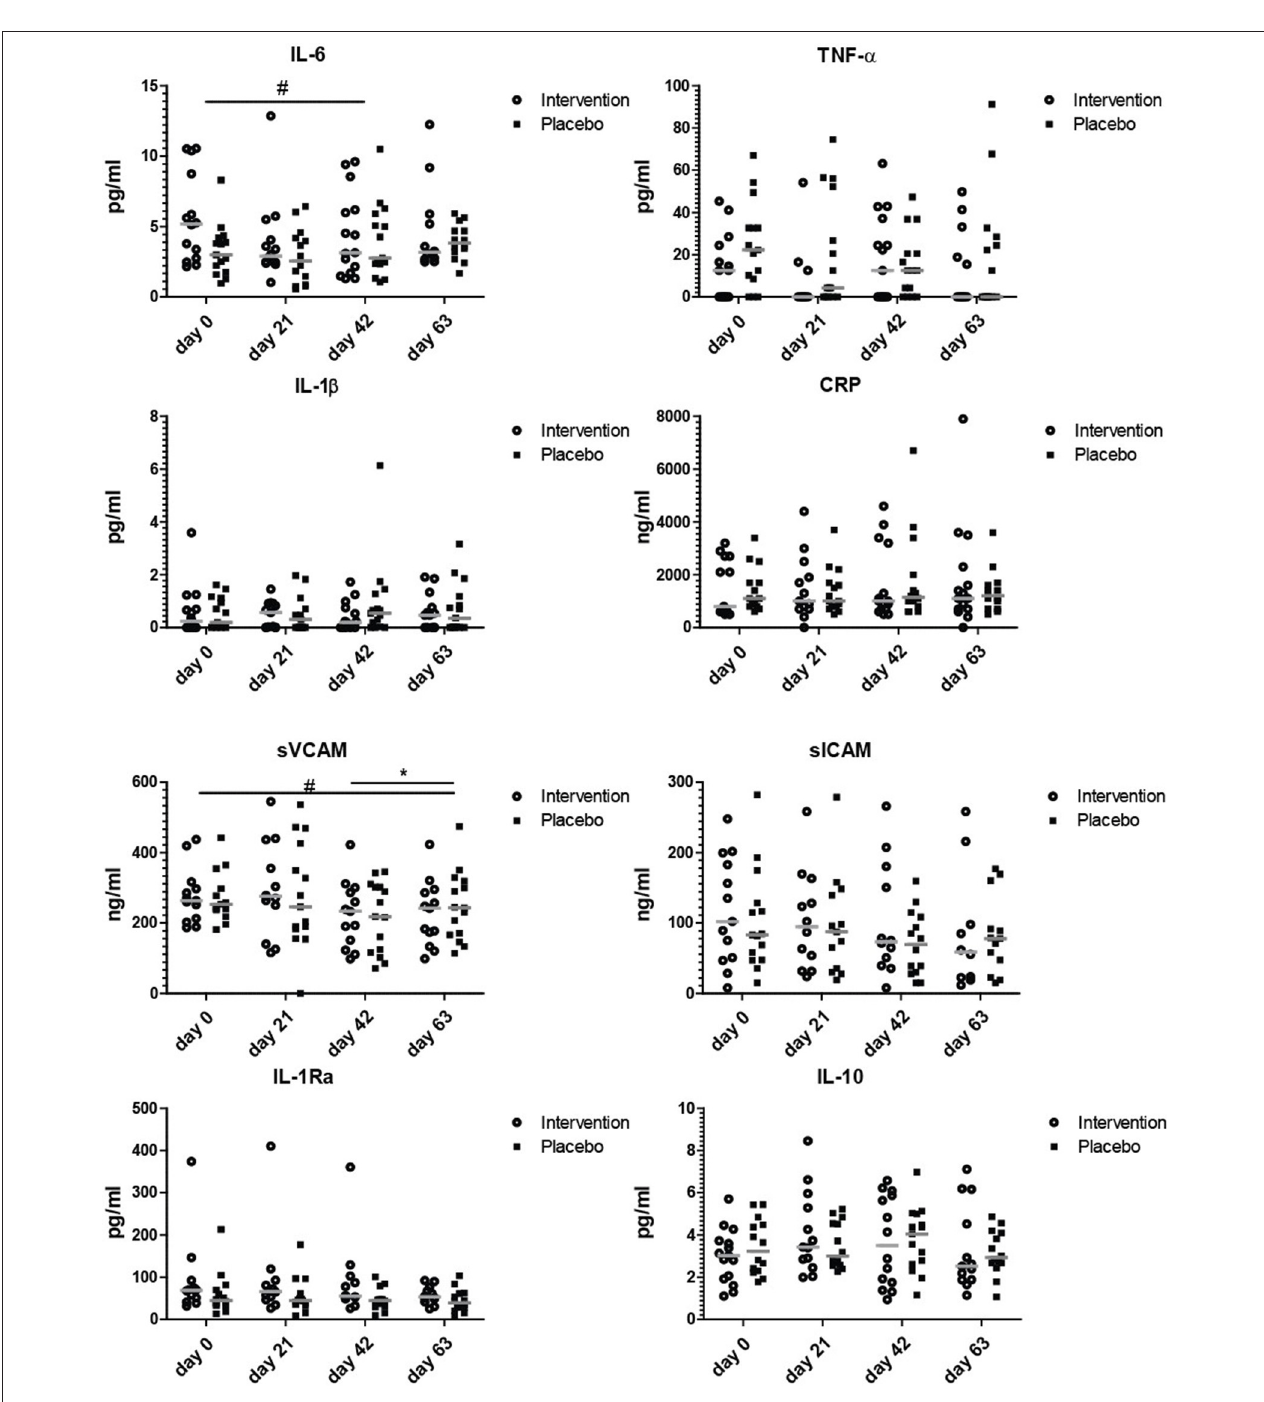
FIGURE 3 | Serum markers involved in inflammation. Concentrations of IL-6, TNF- α , IL-1 β , CRP, sVCAM, sICAM, IL-1RA, and IL-10 at study days 0, 21, 42, and 63. Data shown as scatter plots with median value. Analysis was done on the 10 log transformated data or ranks (IL-1 β and TNF- α ) by repeated measures ANOVA,. Outliers ( > 2 SD )were removed. All statistical differences are differences over time between the nutritional intervention group and the placebo group. * p < 0.05; or # is given for trends.